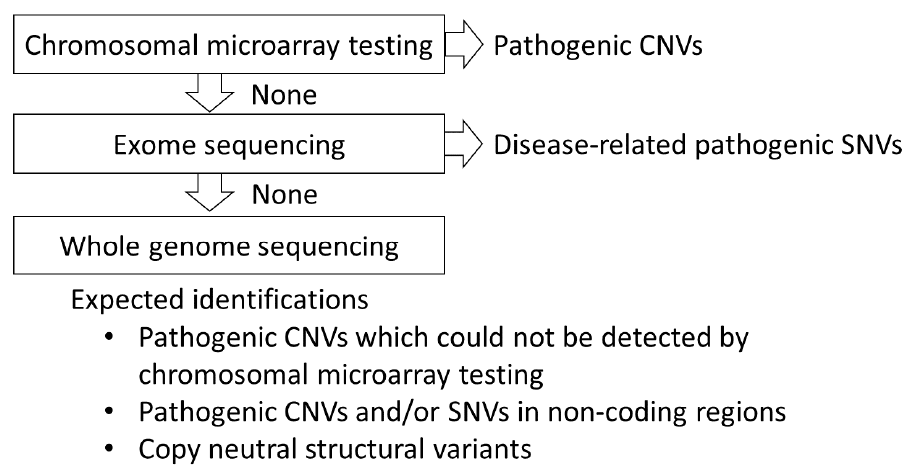
Figure 5. Schematic representation of the stepwise diagnosis for patients with neurodevelopmental disorder.